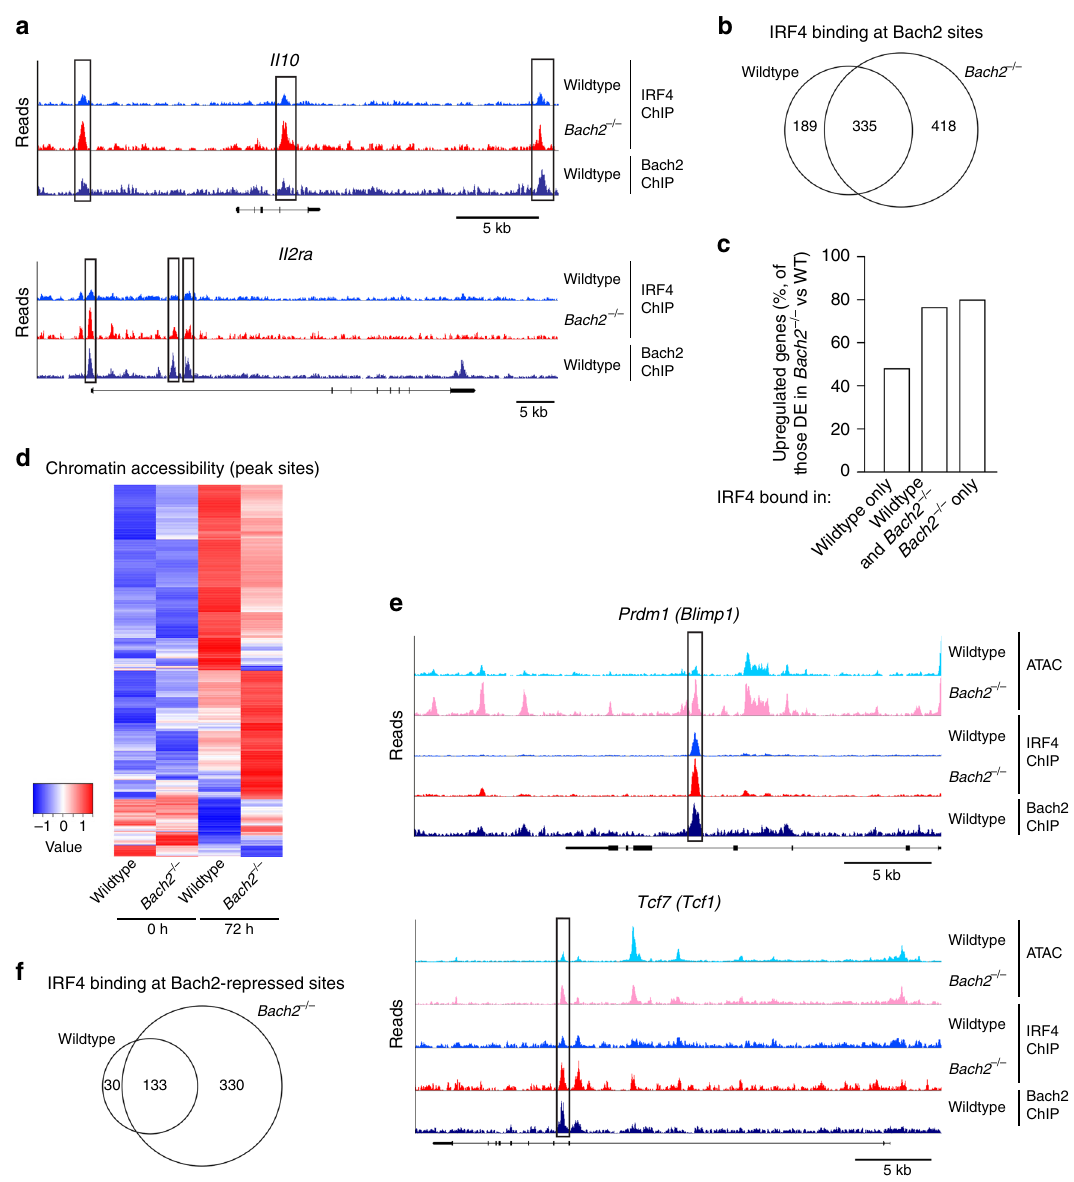
Fig. 8 Bach2 limits DNA accessibility, occupancy and expression of IRF4 target genes. a Bach2 and IRF4 ChIP-seq tracks showing sites of Bach2 and IRF4 co-binding within the Il10 and Il2ra loci of naïve splenic CD4 T cells cultured in Treg cell-inducing conditions. Boxes indicate Bach2 binding sites with increased IRF4 occupancy in the absence of Bach2. b Quanti fi cation of IRF4 and Bach2 co-binding. c Frequencies of differentially expressed genes bound by both Bach2 and IRF4 that are upregulated in the absence of Bach2. d ATAC-seq of naïve splenic CD4 T cells from Cd4 Cre or Bach2 fl / fl Cd4 Cre mice before and after 72 h culture in Treg cell-inducing conditions. Heatmap showing Z -scores of read densities at peaks called differentially accessible between genotypes that also co-localize with Bach2 ChIP-seq peaks. e Example loci showing ATAC-seq, IRF4 ChIP-seq and Bach2 ChIP-seq tracks. Boxes indicate Bach2 binding sites with increased IRF4 occupancy and chromatin accessibility in the absence of Bach2. f Number of IRF4 ChIP-seq peaks called in wildtype or Bach2 − / − cells at sites of differentially accessible chromatin. Source data are provided as a Source Data fi